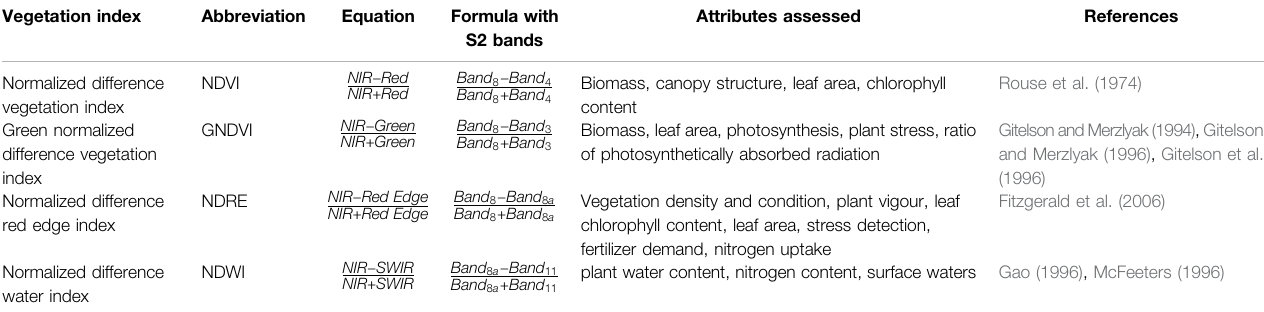
TABLE 1 | Spectral indices calculated in this study. For Sentinel-2 (S2), multispectral wavelength band centres are: Band 3 (560 nm), Band 4 (665 nm), Band 8 (842 nm), Band 8a (865 nm), and Band 11 (1,610 nm). Vegetation index